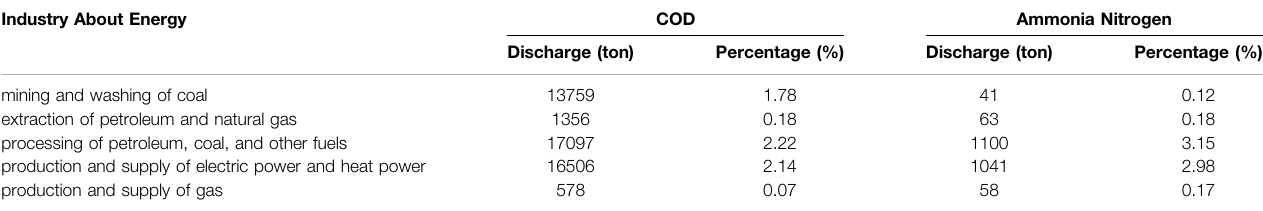
TABLE 3 | Discharge of industrial waste-water and its percentage in some industries about energy in China 2019.